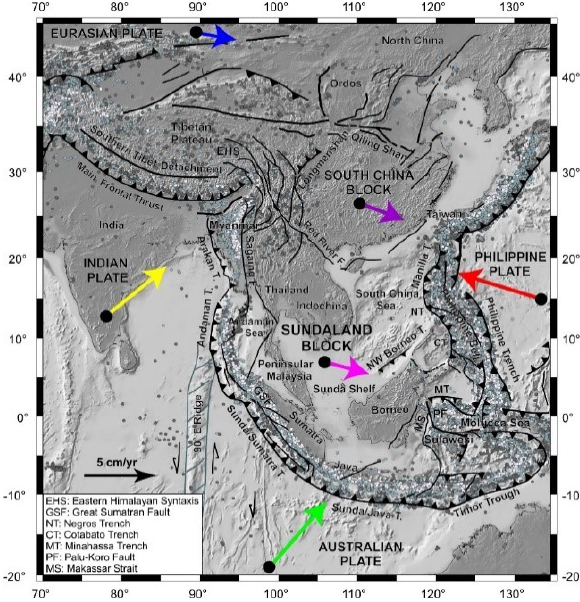
Fig. 1. Absolute/ITRF2000 motions of the Eurasian, Indian, Aus- tralian, Philippine plates and the South China and Sundaland blocks (Simons et al, 2007)